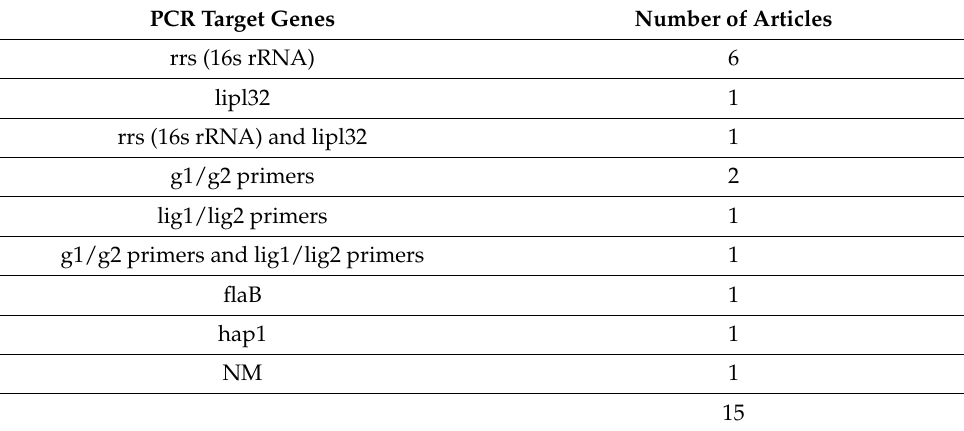
Table 4. PCR target genes used by 15 studies.